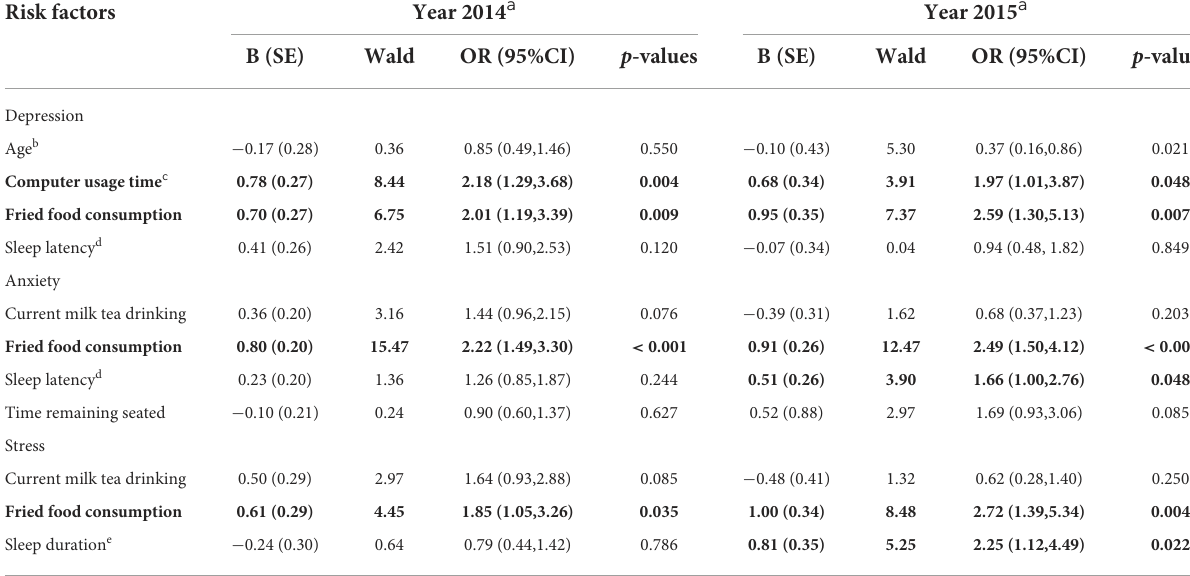
TABLE 3 Association of the prevalence of depression, anxiety, and stress symptoms with lifestyle-related risk factors in 2 years. Risk